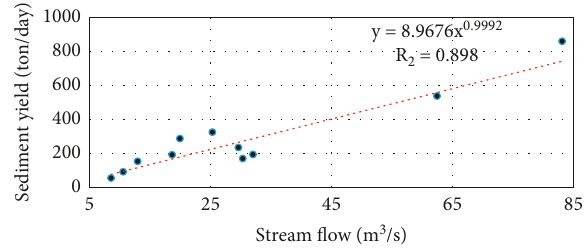
Figure 6: Sediment rating curve at the Awata watershed station.